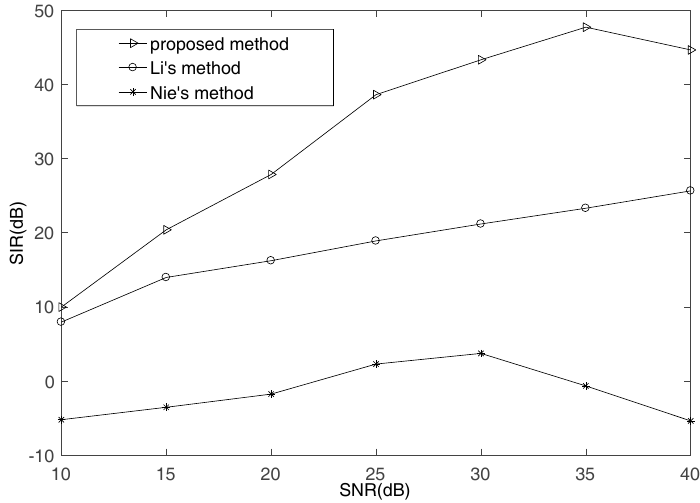
Figure 11 The SIR comparison of different mixing matrix estimation methods. Figure 11. The SIR comparison of different mixing matrix estimation methods.